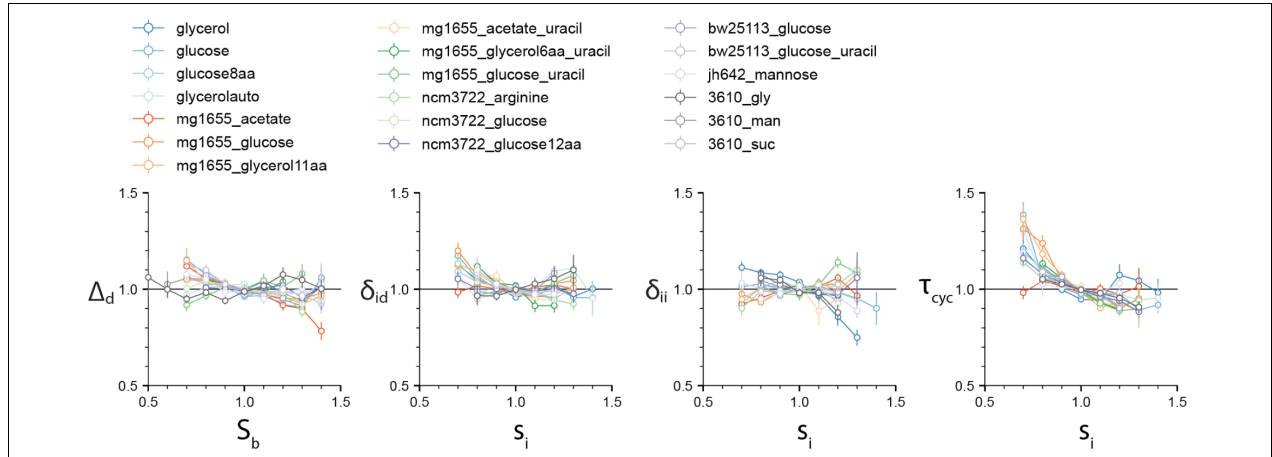
FIGURE 2 | The four correlations ρ ( S b , (cid:49) d ), ρ ( s i , δ id ), ρ ( s i , δ ii ), and ρ ( s i , τ cyc ) are computed for the 4 experimental datasets by Witz et al. (2019), and 15 experimental datasets that we produced (see Supplementary Methods ). While the first three vanish for most experimental data, the ρ ( s i , τ cyc ) displays a consistent negative correlation, inconsistent with the sHC and IA models. Variables in each dataset were normalized by their mean. Numerical values for the Pearson correlation coefficients are given in Supplementary Data 2 file. Slopes can be inferred from the Pearson correlation coefficients and CVs in the approximation of bivariate Gaussian